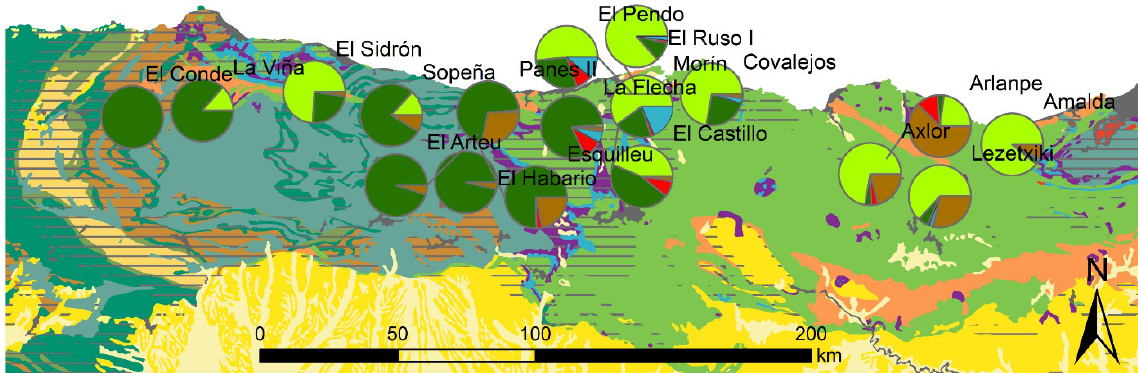
Figure 6. Raw material distribution at each archaeological site during the Mousterian using pie charts. Main chrono-lithological strata in the Cantabrian Region are displayed, based on a 1:1.000.000 geological map (Álvaro et al. 1994). Lithology colours are the same as for Figure 1. Pie chart colours are also the same as in Figure